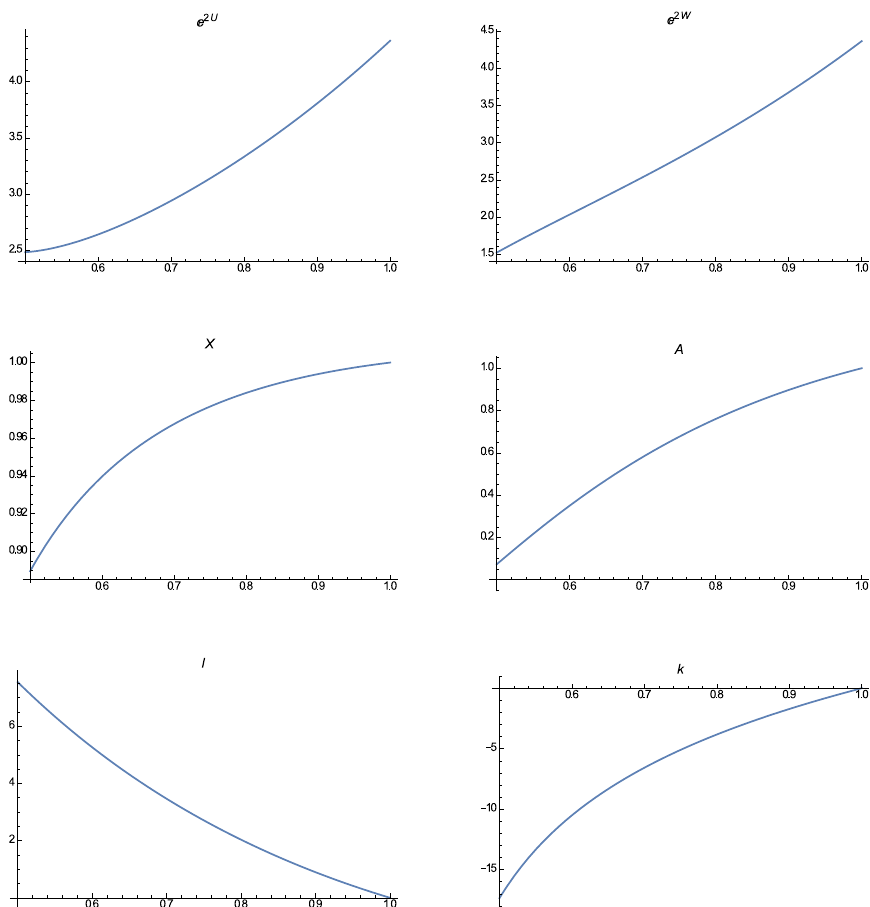
Figure 2 . Flows of e 2 U ( r ) ; e 2 W ( r ) ; X ( r ) ; A ( r ) ; l ( r ) ; k ( r ) plotted in the interval r 2 (0 : 5 ; 1] with g = 3 1 = 5 7 3 = 10 , h = g , (cid:20) = 2, L = 0 : 3 and V ( r ) = p 2 1 = 10 2 2